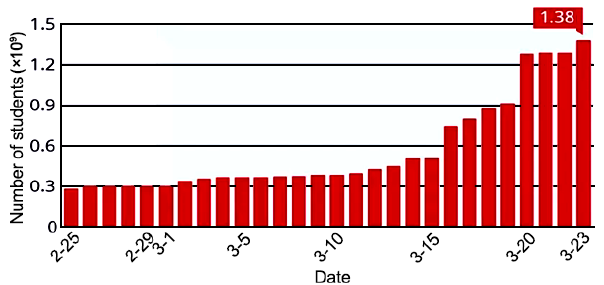
Fig. 1 Number of students affected by nationwide school closures globally as of March 23,